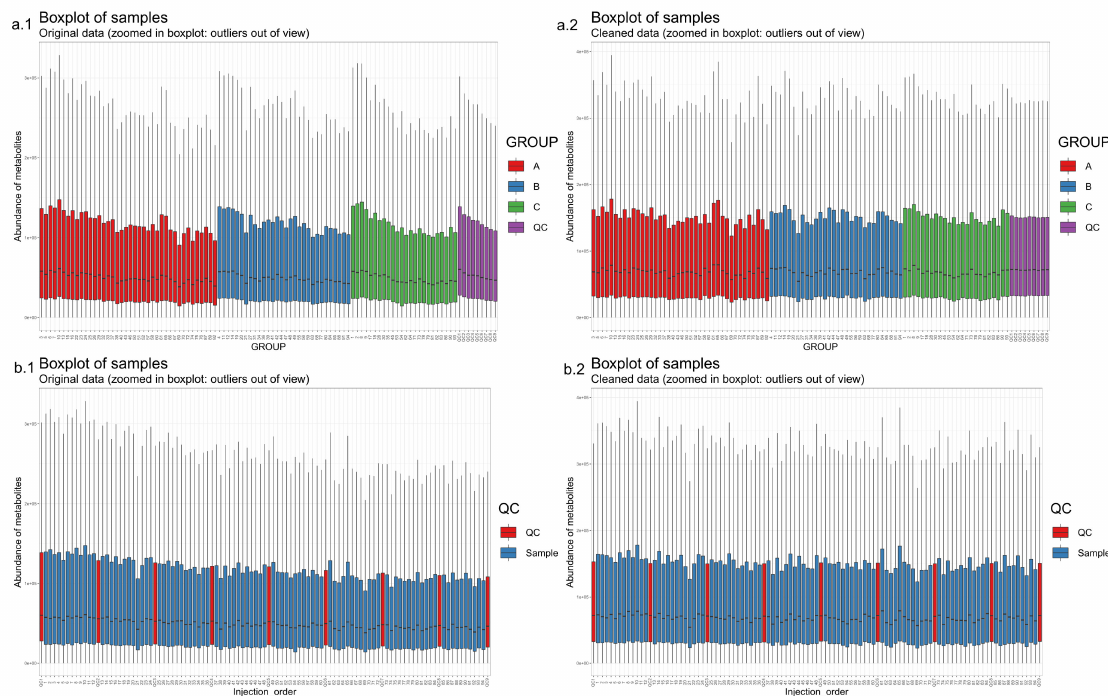
Figure 6. Boxplots of feature intensities per sample. The boxplots ( a.1 ), where the samples are ordered by study group ( a.1 ) and ( b.1 ), where the samples are ordered by injection order and quality control (QC) samples are colored distinctly ( b.1 ), show a clear systematic decrease in signal intensity during the injection sequence. After the drift correction, the drift pattern is no longer observable (in boxplots a.2 and b.2 ). Metabolites 2020 , 10 , x FOR PEER REVIEW